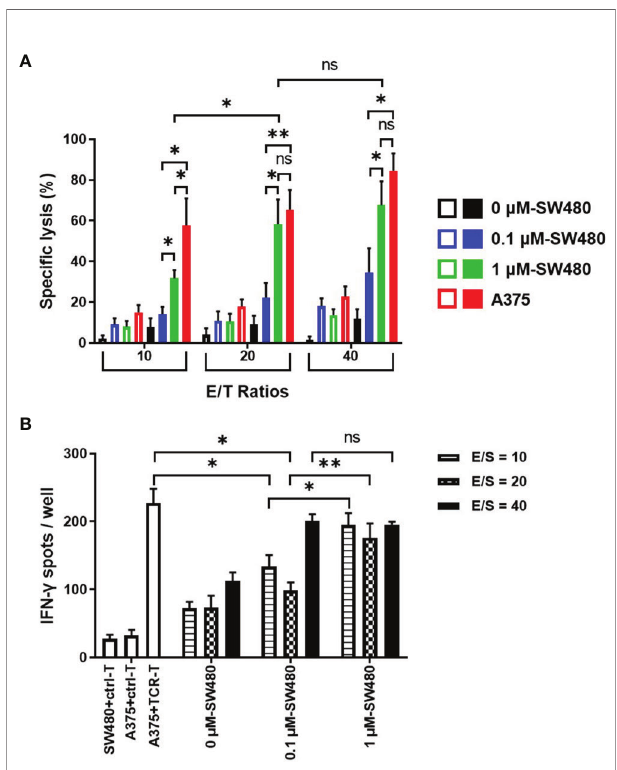
FIGURE 4 | More potent speci fi c lysis to the DAC treated tumor cell lines by the TCR-T cells in vitro . (A) LDH assay for the cytotoxicity. The TCR-T cells were used as effector cells (E) and SW480 cells treated without or with 0.1 m M, 1 m M DAC as target cells (T). Various E/T ratios were tested as indicated. LDH spontaneous release of the target cells was less than 20%. Results shown were mean ± SD of quadruplicate wells. (B) ELISPOT assay for IFN- g release by the TCR-T cells. The target cells in the cytotoxicity assay were used as stimulators (S). SW480 cells were treated without or with 0.1 m M, 1 m M DAC. Various E/S ratios were tested as indicated. A375 melanoma cell line was selected to be the positive stimulator cells for the high-expressed NY-ESO-1. The IFN- g spot-forming cells (SFCs) were counted and analyzed by CTL-ImmunoSpot S6 Ultimate Micro Analyzer. ns: no signi fi cance. *P<0.05;